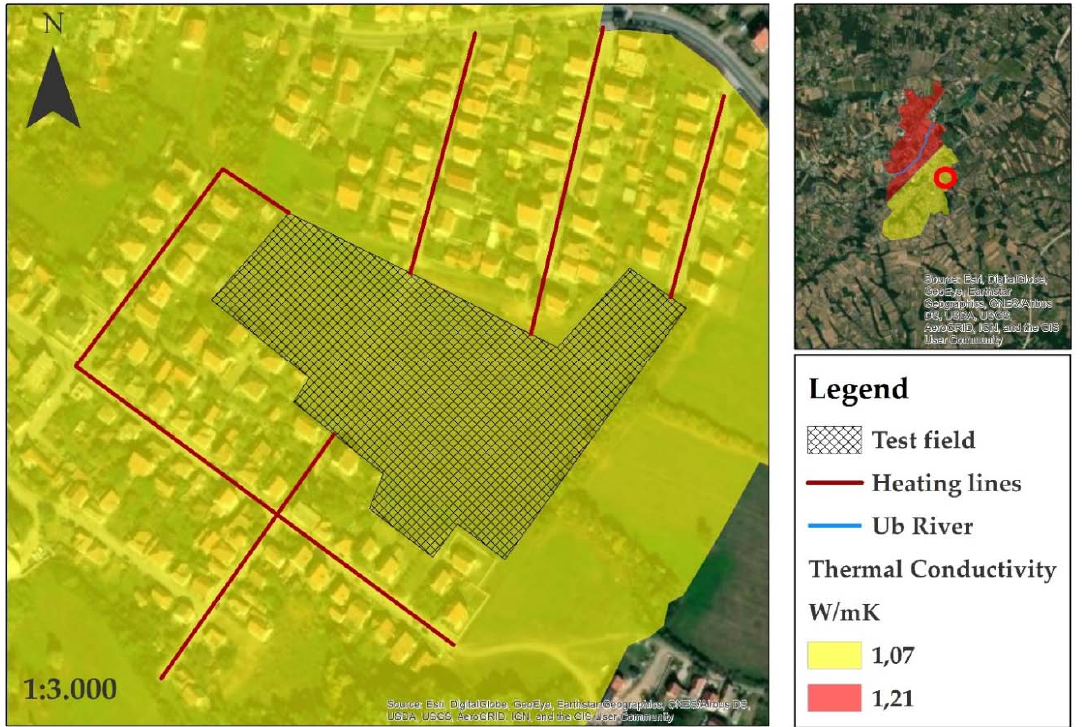
Figure 6. Potential test field in Ub and its surrounding (own map based on ThermoMap ).